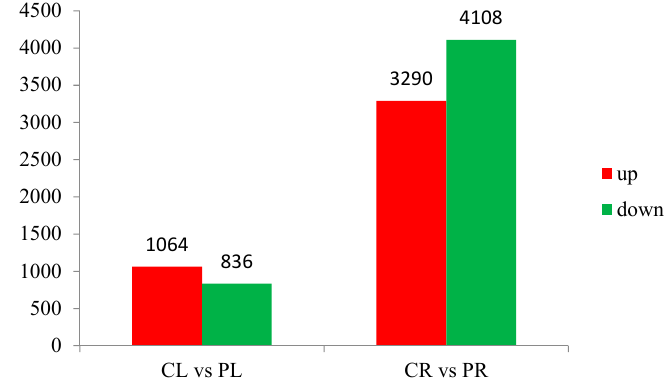
Figure 3. Differentially expressed genes (DEGs) in aboveground and root components during P starvation treatment. CL: Aboveground part of WT; CR: Root of WT; PL: Aboveground section of − P treatment; PR: Root of − P treatment.